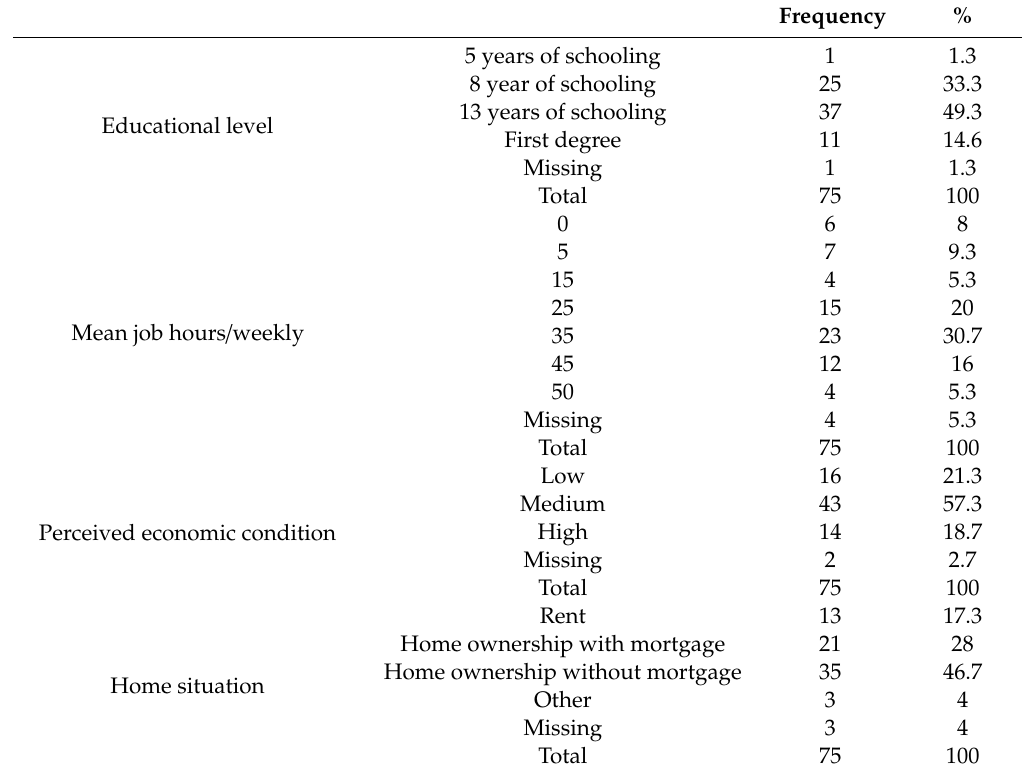
Table 2. Participants’ education and their family